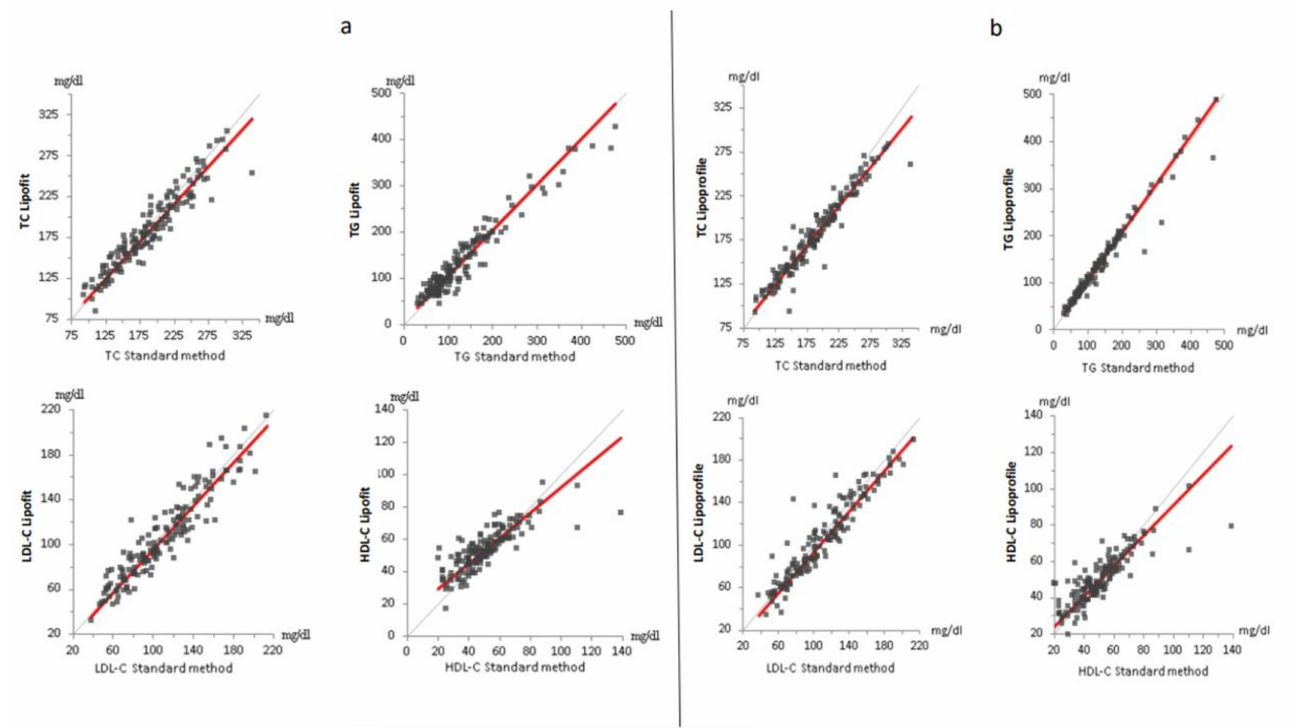
Figure 1. Comparison of standard lipids between ß-quantification and lipofit NMR ( a ) and lipoprofile NMR ( b ). The ( a , b ) show the Passing–Bablok regression for total cholesterol (top left), triglyc- erides (top right), low-density lipoprotein cholesterol (bottom left), and high-density lipoprotein cholesterol (bottom right). The respective slopes of the regression lines (red) were 0.889 (TC), 1.027 (TG), 0.960 (LDL-C), and 0.830 (HDL-C) for lipofit and 0.914 (TC), 0.983 (TG), 0.973 (LDL- C), and 0.786 (HDL-C) for lipoprofile, respectively. The grey line represents the line of identity. (C = cholesterol. HDL = high-density lipoproteins. LDL = low-density lipoproteins. TC = total cholesterol. TG =